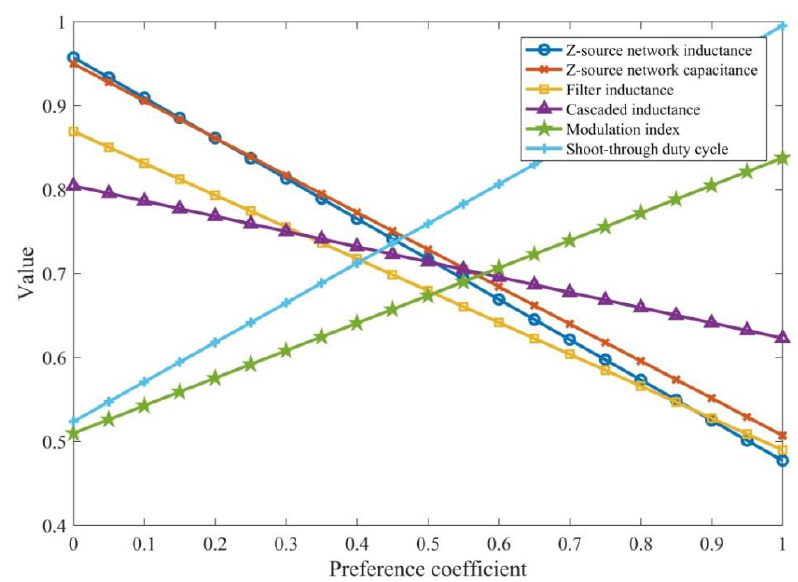
Figure 6. Comprehensive correlation degrees of LVC-qZSI parameters.